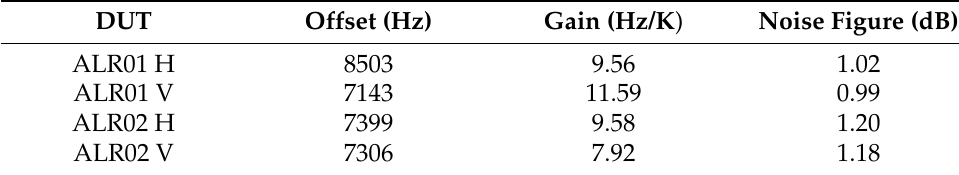
Table 1. Parameters of PMS